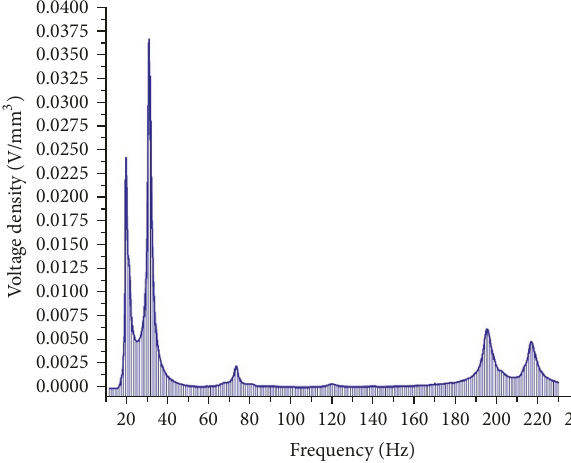
Figure 14: Measured voltage density in frequency domain.